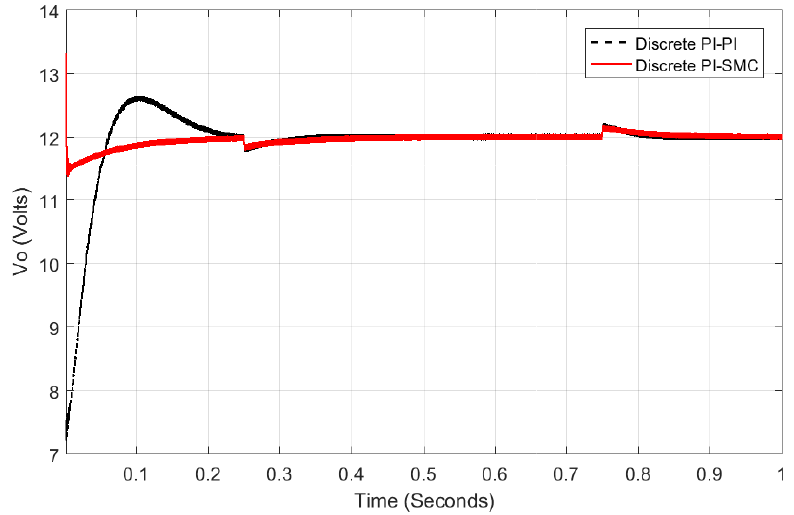
Figure 15. Simulation of the output voltage V o of the converter in the case of load perturbation.